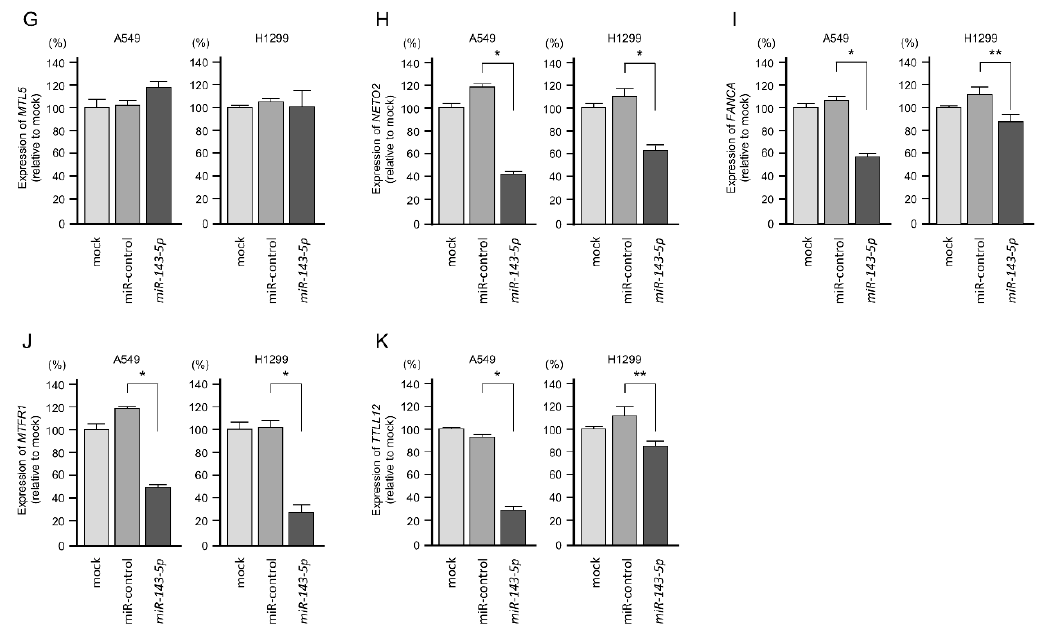
Figure 6. Expression of miR-143-5p target genes was evaluated using quantitative real-time reverse transcription polymerase chain reaction (qRT-PCR). ( A ) MCM4 , ( B ) RAD51 , ( C ) FAM111B , ( D ) CLGN , ( E ) KRT80 , ( F ) GPC1 , ( G ) MTL5 , ( H ) NETO2 , ( I ) FANCA , ( J ) MTFR1 , ( K ) TTLL12 . Expression of GAPDH was used as an internal control (* p < 0.001, ** p < 0.05).